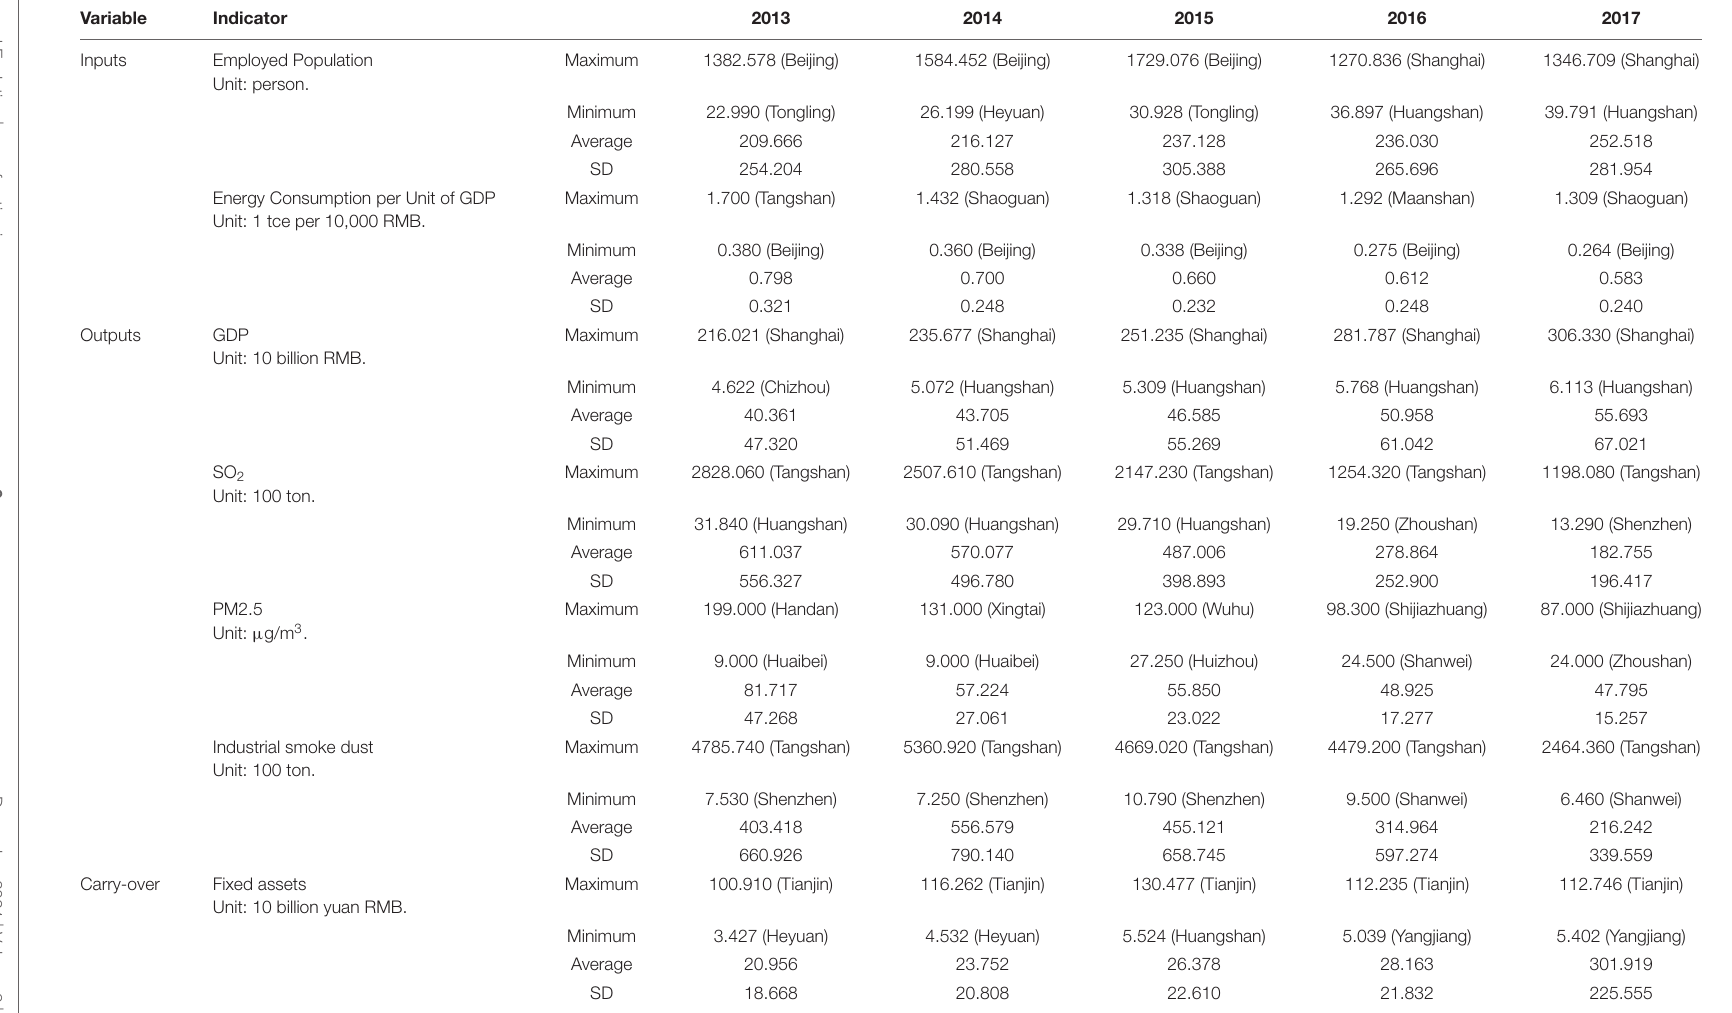
TABLE 3 | Description of